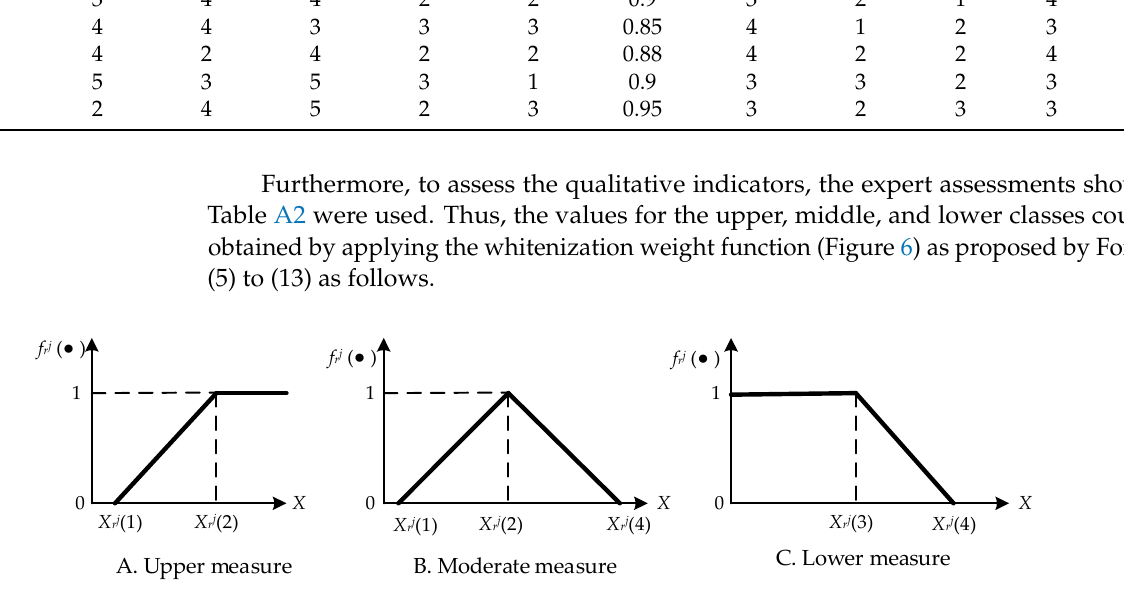
Table 11. The observed values of each criterion for each incoming core ( X sr ).